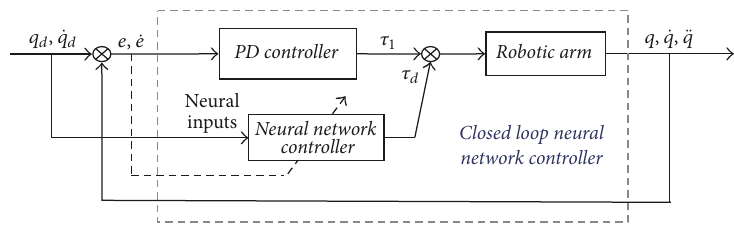
Figure 5: A basic structure of the adaptive NN robot